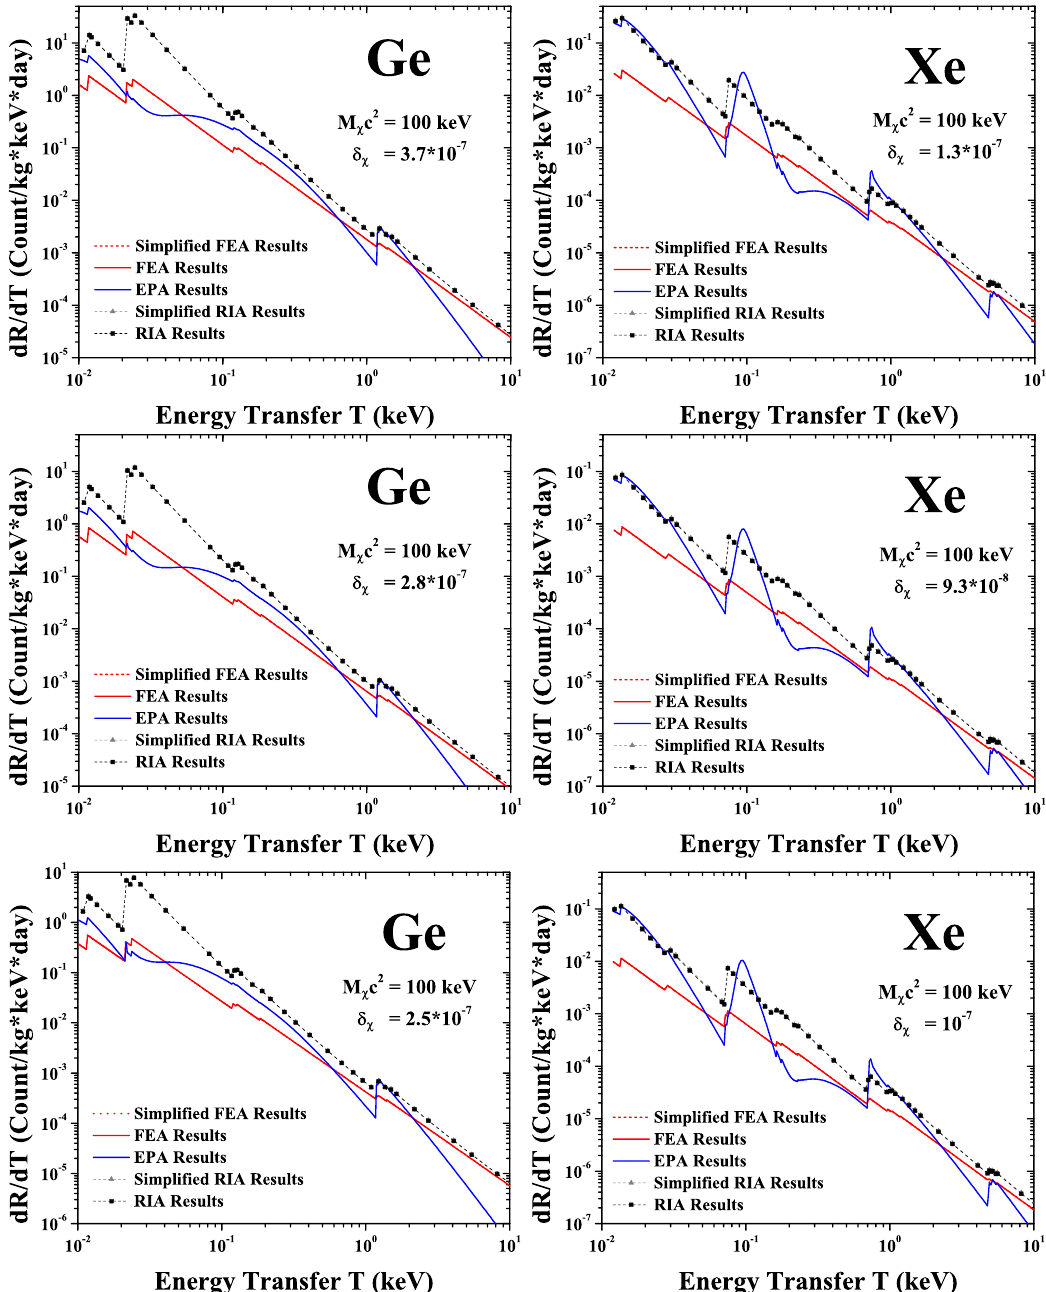
Figure 14 . The differential reaction event rates for the atomic ionization process induced by millicharged particles in HPGe and LXe detectors. The mass of millicharged dark matter particle is set as m is chosen such that the reaction event rates in HPGe 2 = 100 keV, and its millicharge δ χ c χ and LXe detectors match the experimental background levels for next-generation experiments, respectively. In this figure, the horizontal axis represents the energy transfer T , and the vertical axis represents the differential event rate dR/dT in unit of cpkkd. The same as in figure 6 and figure 9, the red solid lines correspond to the FEA results; red dashed lines represent the simplified FEA results; blue lines stand for the EPA results; black squares display the RIA results; gray triangles show the simplified RIA